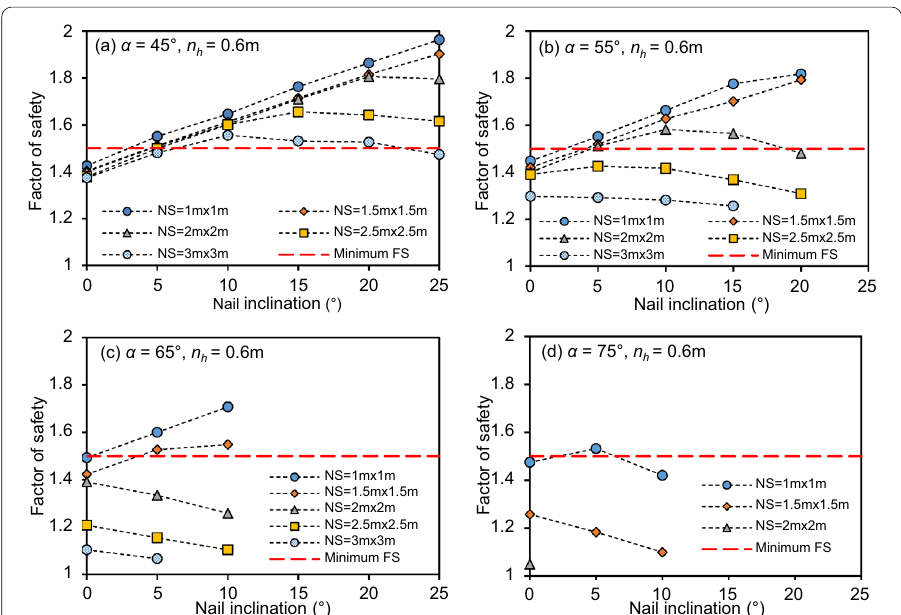
Fig. 7 The effect of nail head size equal to 0.6 m in four different slope angles